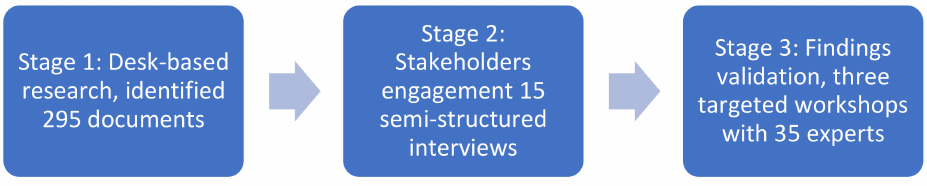
Figure 2. Research design. Source: